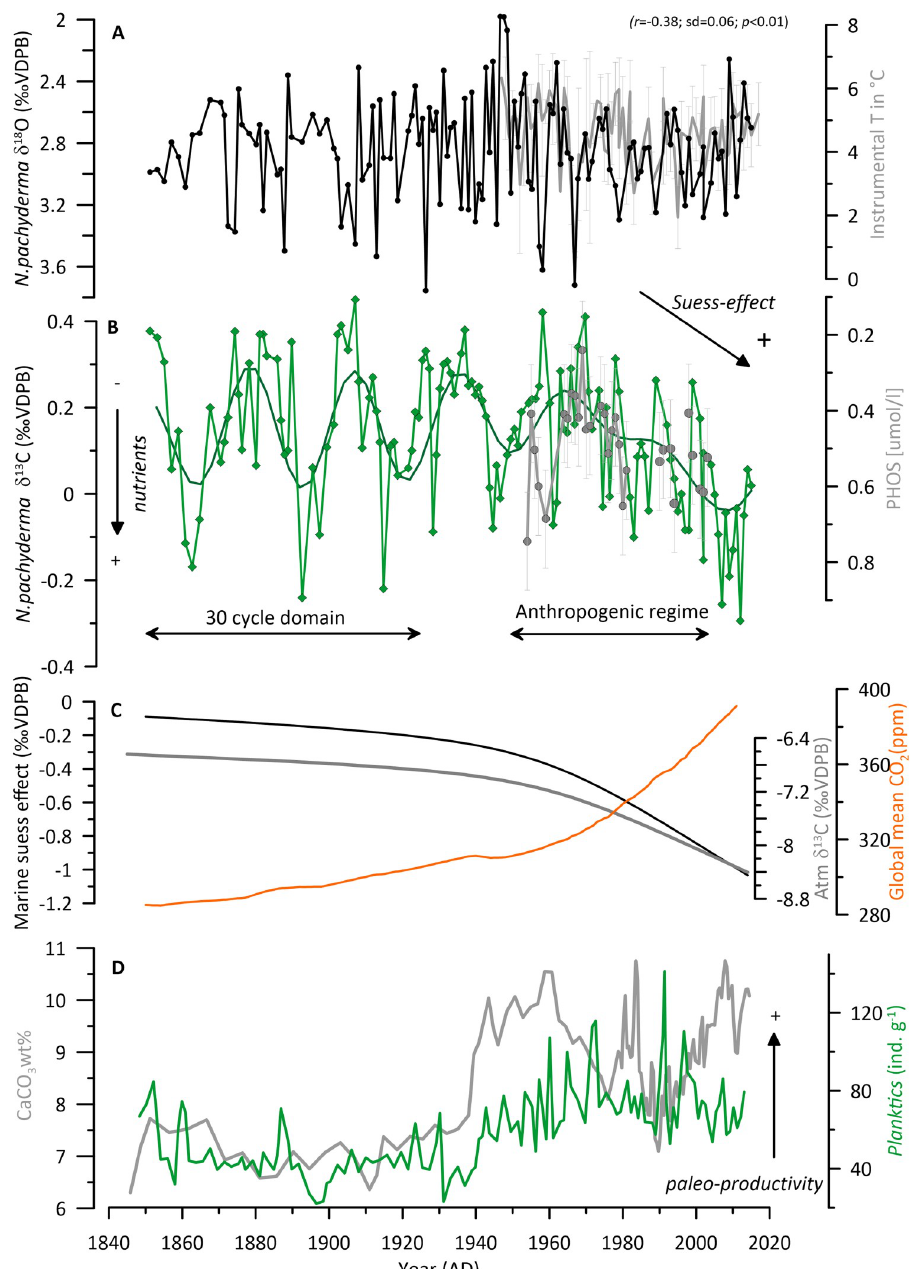
Fig 4. Comparison of proxies against instrumental observations and evaluation of the Marine Suess effect at core site GS15-198 33. (A) δ 18 O time series of N . pachyderma in black against instrumental temperature measurements (1SD) from Hunafloi station in grey (HF 3: 66.5 N; 20.78 W; S1 Fig in S1 File). Continuous instrumental data for that station was only available after 1974, hence we use data from the Siglunes section, situated further east and operated since 1947 (SI3: 66.32 N; 18.50 W; S1 Fig in S1 File) for the comparison in the older part of the record; coefficient of correlations r and 2 standard deviations are shown for reference. (B) δ 13 C time series of N . pachyderma in comparison with measured phosphate concentration ( μ mol kg − 1 ) in grey in the upper 200m on the NIS (68–66 ˚N, 22–18 ˚W; S2 Fig in S1 File) data retrieved from the International Council for the Exploration of the Sea (ICES) database: https:// ocean.ices.dk/https://ocean.ices.dk in a narrow grid cell; δ 13 C of N . pachyderma is shown with the 25-yrs high-pass filter on top to highlight the significant ~30 cycle identified in the frequency analysis (Fig 3F). Indicated are the time intervals of significant multi-decadal frequency compared to before 1950´s and after when the Marine Suess effect dominates the regime. (C) estimated Marine Suess effect on the NIS at 100 m water depth in black; atmospheric δ 13 C